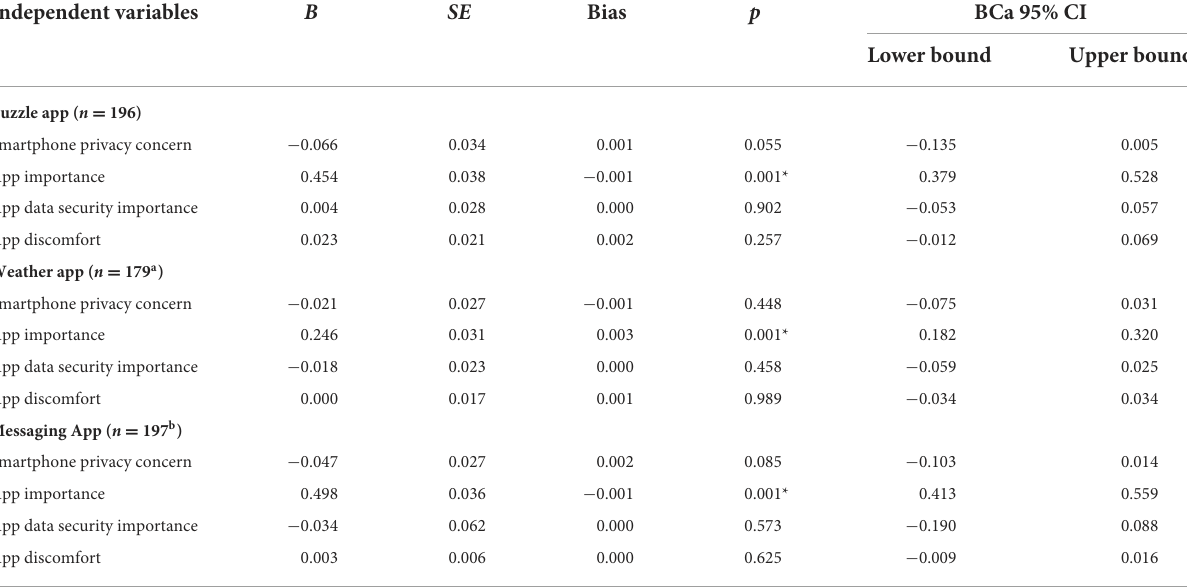
TABLE 3 Results of bootstrapped multiple regression analyses with intention of installing the app as dependent variable, study 2. Independent